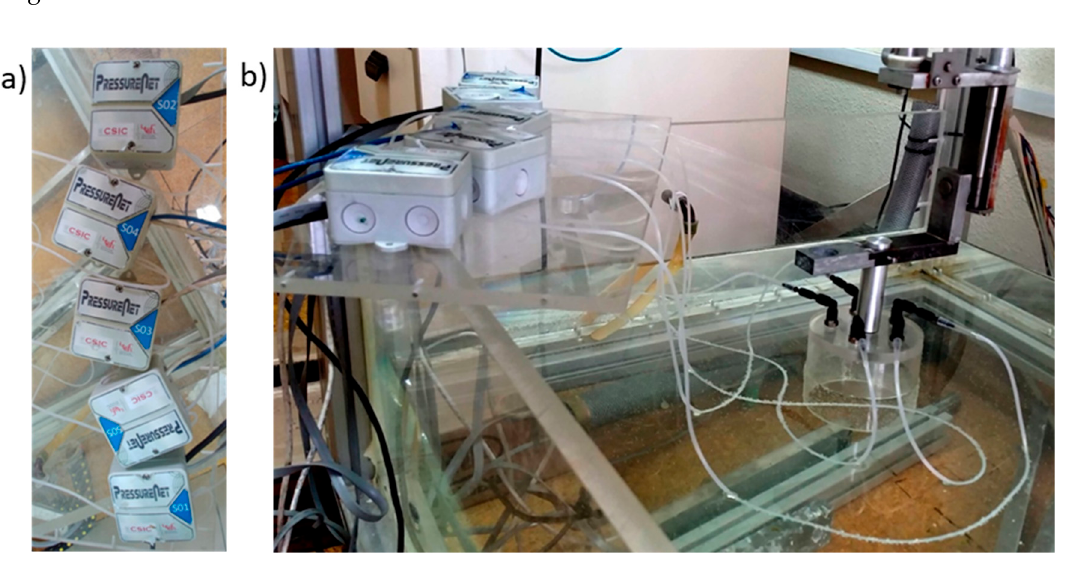
Figure 4. ( a ) Five pressure sensors used in the experiment and ( b ) pressure sensors connected to the air pressure chamber.